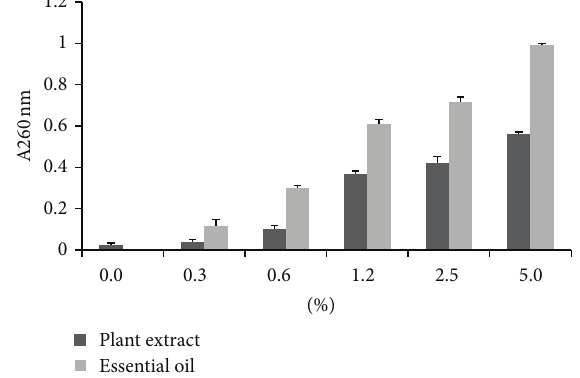
Figure 2: The effect of crude extract and essential oil from Salvia sclarea on the leakage of 260nm absorbing materials from Staphylococcus epidermidis